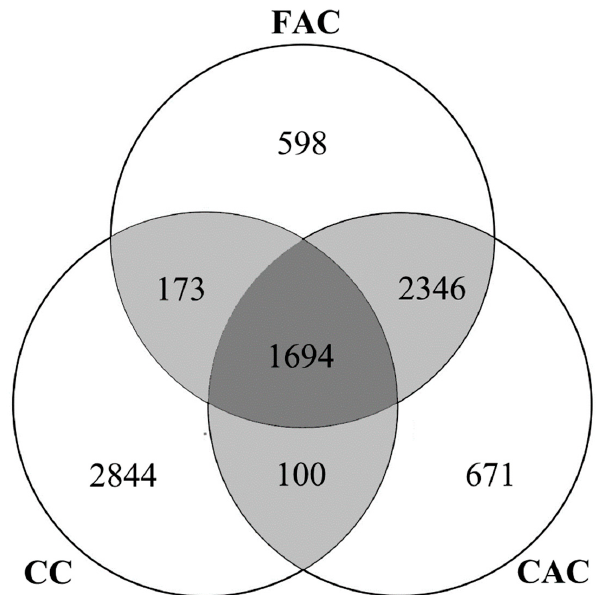
Figure 8. The nonproportional Venn diagram showing subsets of numbers of new species described based on the countries of the first author (FAC), the corresponding author (CAC), and collecting country of holotype (CC). Dark gray represents the species for which the FAC, CAC, and CC are the same, and light gray indicates the species for which two of the three types (FAC, CAC, and CC) are the same.